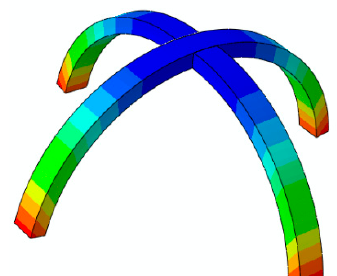
Figure 12. The FE Abaqus simulation of the self-bending gripper illustrated in Figure 11.